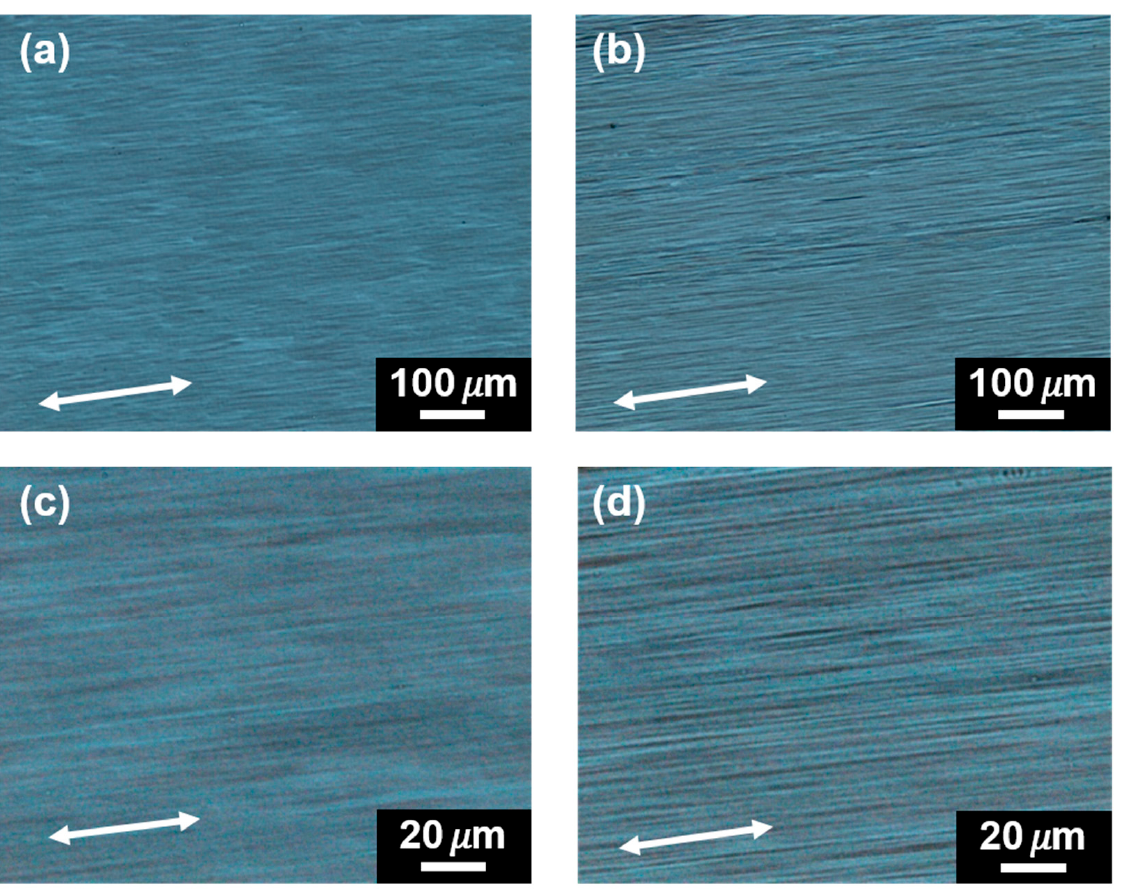
Figure 8. Polarized optical micrographs of a PLLA film friction transferred at 100 °C before ( a , c ) and after ( b , d ) being immersed in acetone solvent. The friction transfer direction is indicated by an ar- row.